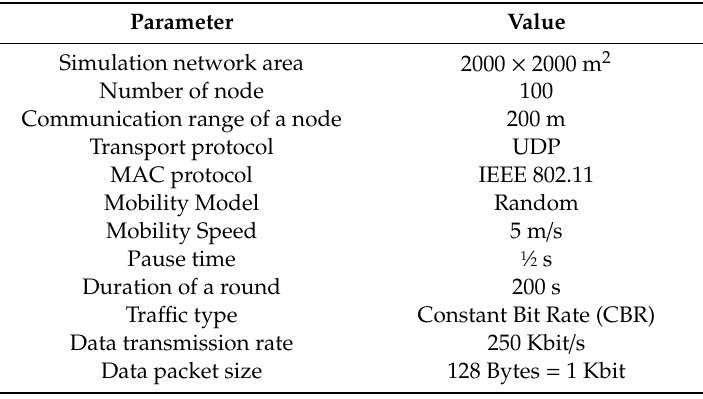
Table 1. Simulation Parameters and